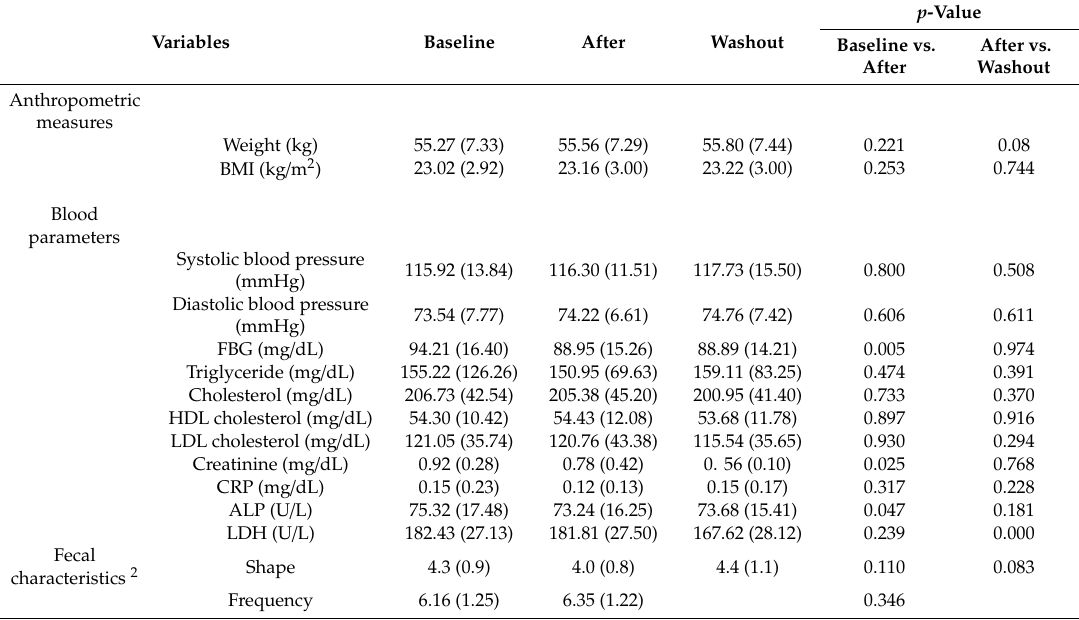
Table 2. Changes of anthropometric measurements, biochemical parameters, and fecal characteristics at each timepoint 1 .